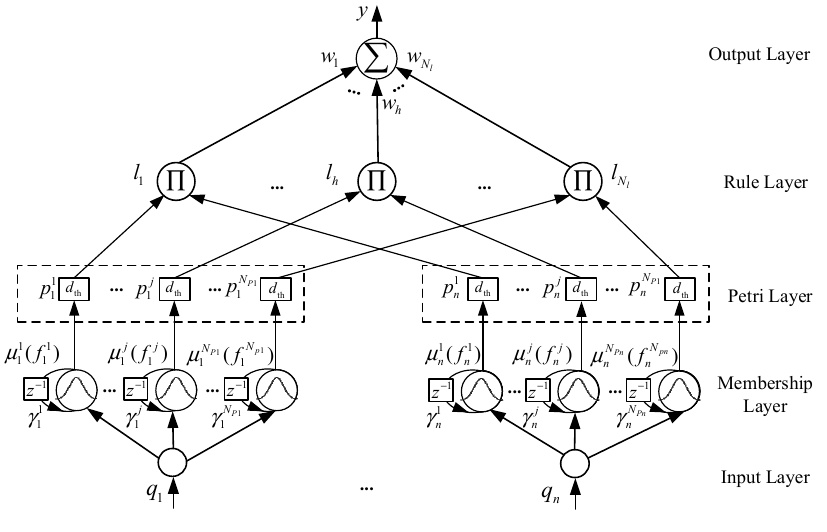
Figure 3. Framework of